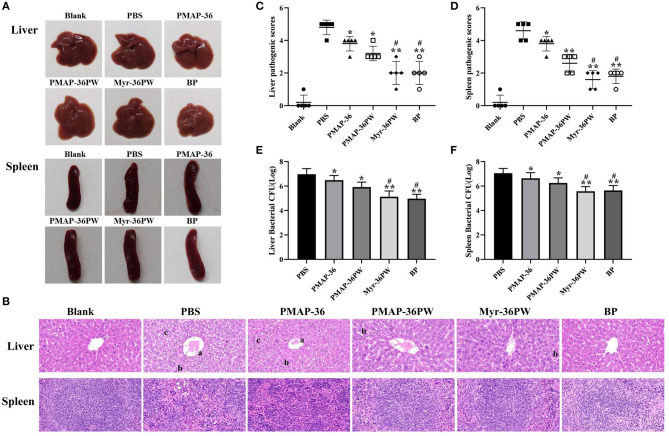
Therapeutic potency of peritonitis by Myr-36PW in vivo. The livers and spleens (n = 5) in each group were collected on day 4 after the intraperitoneal injection of S. aureus ATCC 25923. (A) Morphological changes in liver and spleen tissues. (B) Representative histopathological images of processed liver and spleen sections with hematoxylin and eosin (H&E) staining. Images are presented at a magnification of 40×. a: central venous hemorrhage. b: the cells fuse into pieces, and the nucleus dissolves and disappears. c: cytoplasmic cavitation. (C,D) Pathological scores of the liver and spleen sections. Scoring standard: 1 indicated no pathology, 2 indicated perivascular infiltrates, 3 indicated perivascular or interstitial infiltrates affecting <20% of the section, 4 indicated perivascular or interstitial infiltrates affecting 20–50% of the section, and 5 indicated perivascular or interstitial infiltrates affecting >50% of the section. (E,F) Bacterial CFU in liver and spleen homogenate. BP is benzylpenicillin potassium. Data represent the mean ± SD of five individual experiments. The number of bacteria (CFU) was displayed in the form of Log. *P < 0.05 and **P < 0.01, compared with PBS. #P < 0.05, compared with PMAP-36PW.